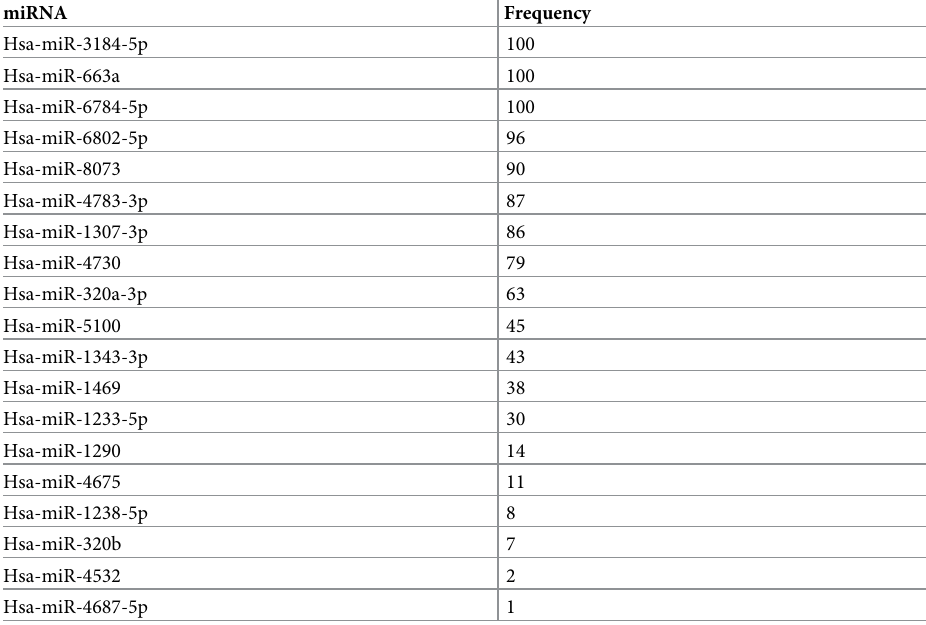
Table 2. Frequency of top miRNAs in 100 random forest models.